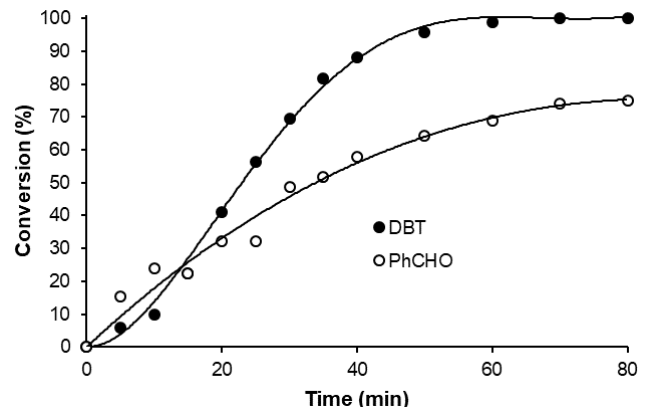
Figure 5. Time course for aerobic co-oxidation of DBT (0.50 mmol) and PhCHO (4.9 mmol) catalyzed by HPA-1 (0.10 g, 0.048 mmol) at 100 ◦ C, 10 mL dodecane, 20 mL min − 1 air flow and 1300 rpm stirring speed.